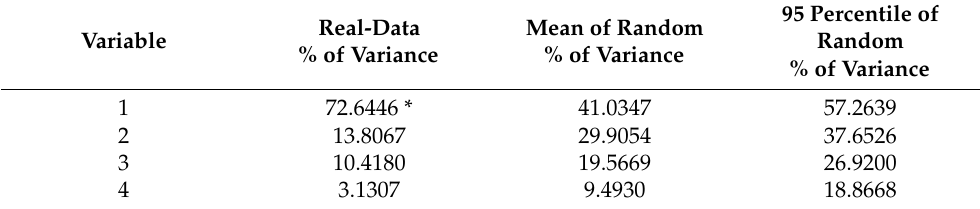
Table 2. Parallel